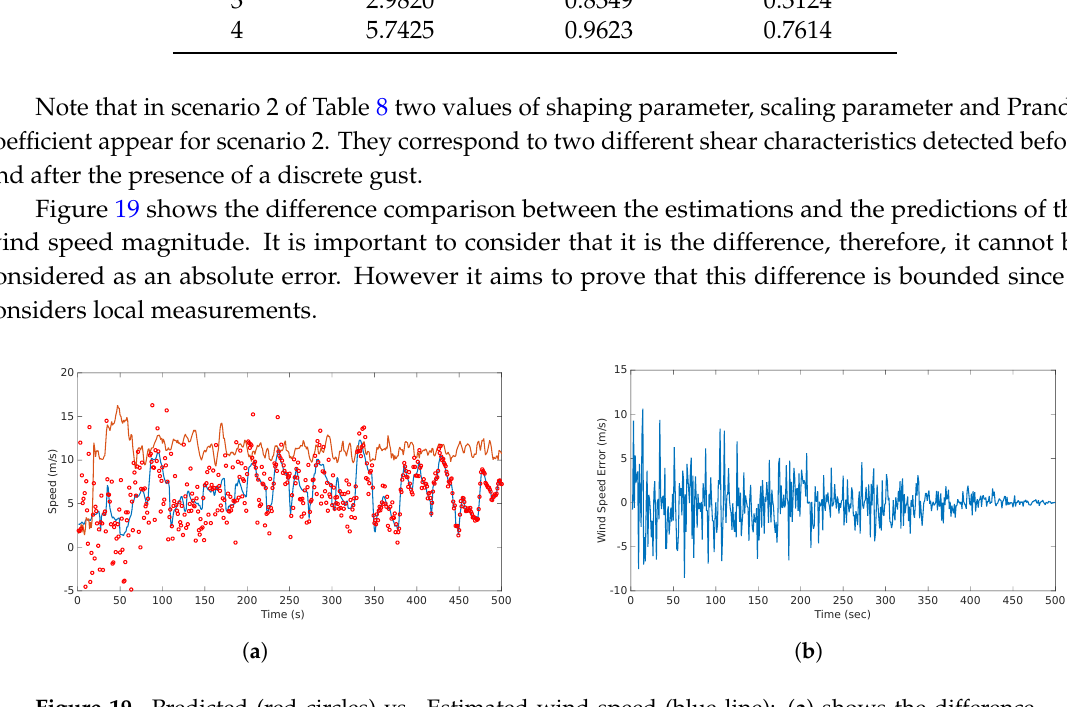
Figure 19. Predicted (red circles) vs. Estimated wind speed (blue line): ( a ) shows the difference between the estimation and the prediction of the wind speeds with the airspeed (orange) as a reference; ( b ) shows the actual difference between these two quantities which appears to be bounded and shows a normal